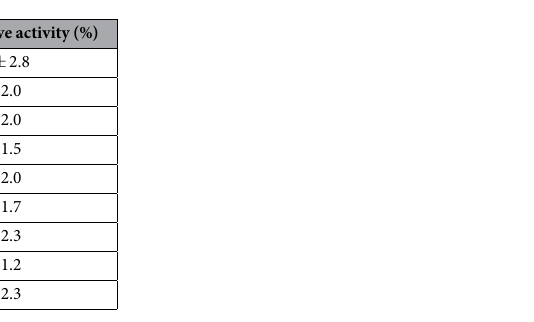
Table 2. The enantioselectivity and relative activity of Tm1743 double mutants towards